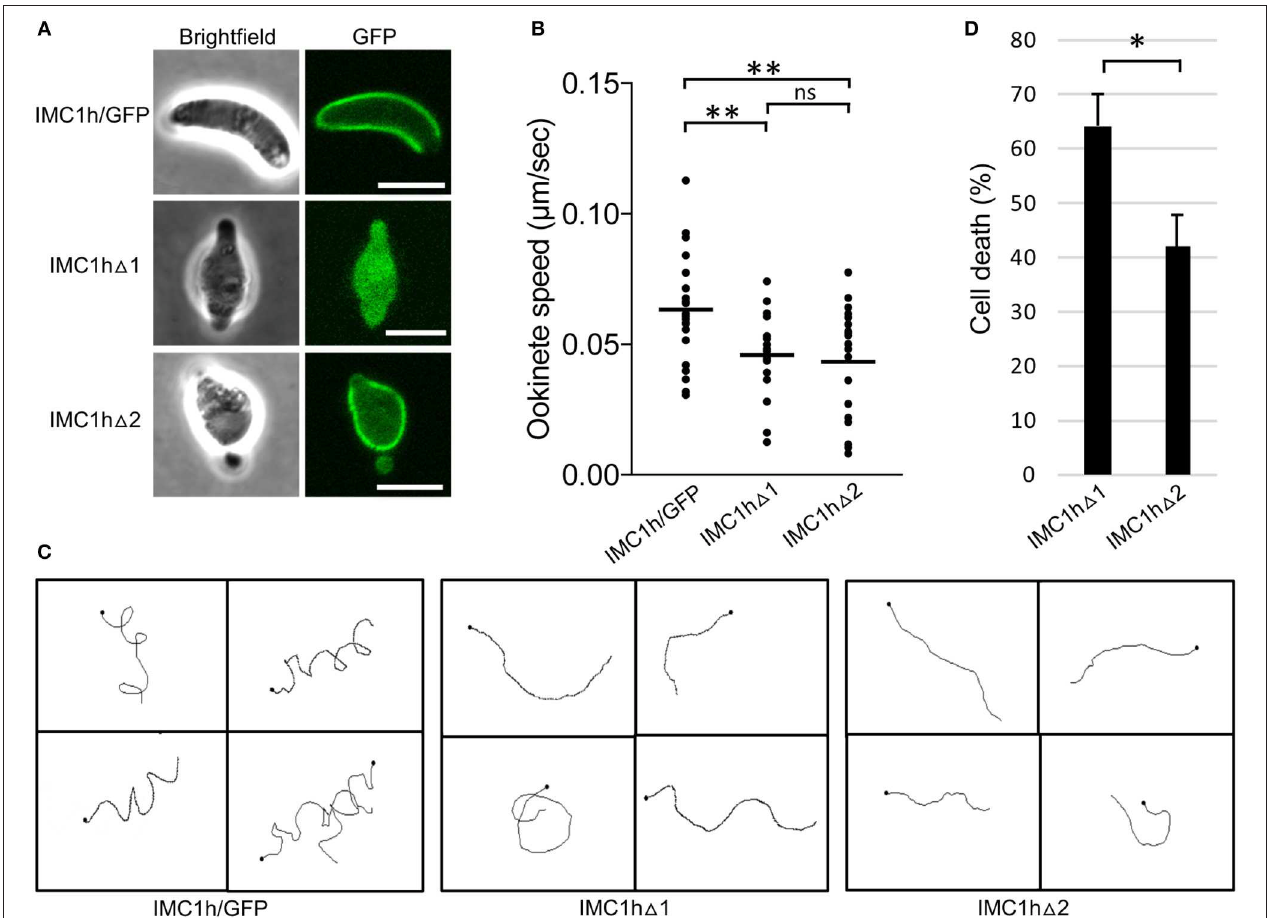
FIGURE 2 | Ookinete-specific subcellular localization of IMC1h::GFP in IMC1h mutants, and their phenotypes. (A) Confocal GFP fluorescence and brightfield images of ookinetes of IMC1h mutant parasite lines. Note that IMC1h 1 2 ookinetes have abnormal shape, but display normal cortical localization of the GFP fusion protein. Scale bar = 5 µ m. (B) Ookinete speed expressed in µ m/sec. Images were captured every 10s over a 10min period. Plot is based on pooled data from two independent experiments and > 60 ookinetes analyzed. Horizontal lines mark mean values. **statistically significant differences ( P < 0.05). ns, not significant. (C) Representative images of reconstructed 3D movement patterns from time-lapse movies of IMC1h mutants in Matrigel. The trajectories reveal the much straighter movement of IMC1h 1 1 and IMC1h 1 2 ookinetes compared to the helical movement of IMC1h/GFP ookinetes. (D) Percentage cell death after hypo-osmotic shock (0.5 × normal strength for 5min). Cell death inversely correlates to tensile strength. *statistically significant differences ( P < 0.05). Error bars indicate S.E.M. values from four independent experiments. ( P < 0.05, t -test) reduced oocyst numbers compared to IMC1h/GFP control parasites ( Table 1 ), indicating that they are less infective than their wildtype counterparts. IMC1h 1